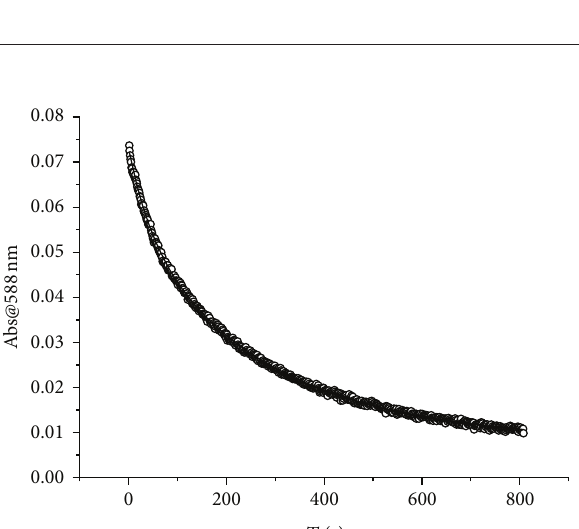
Figure 10: UV absorption spectrum of a bis-spiropyran ( 2b ) in acetonitrile solution before and after continuous irradiation with = 365 nm ( [ c ] = 1.86 ⋅ 10 −4 M; 𝑇 = 293 ∘ K; curves are recorded 𝜆 max with 15 s interval).